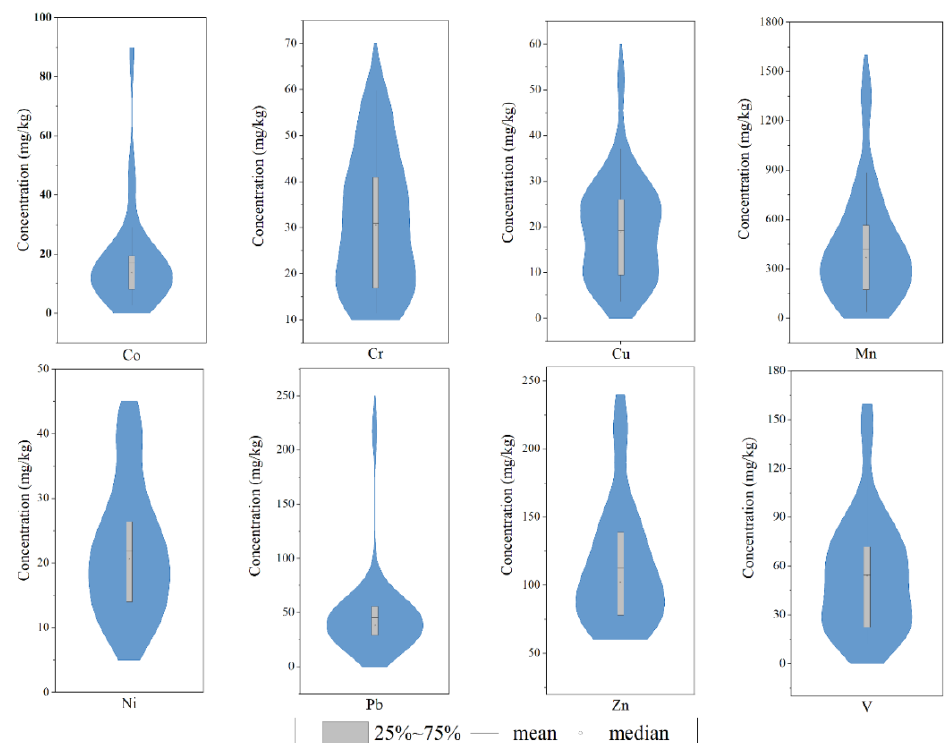
Figure 2. Pseudo-total contents of potentially toxic elements in soil in the study area. Solid lines indicate the mean values determined in this study; circles indicate the median values determined in this study.